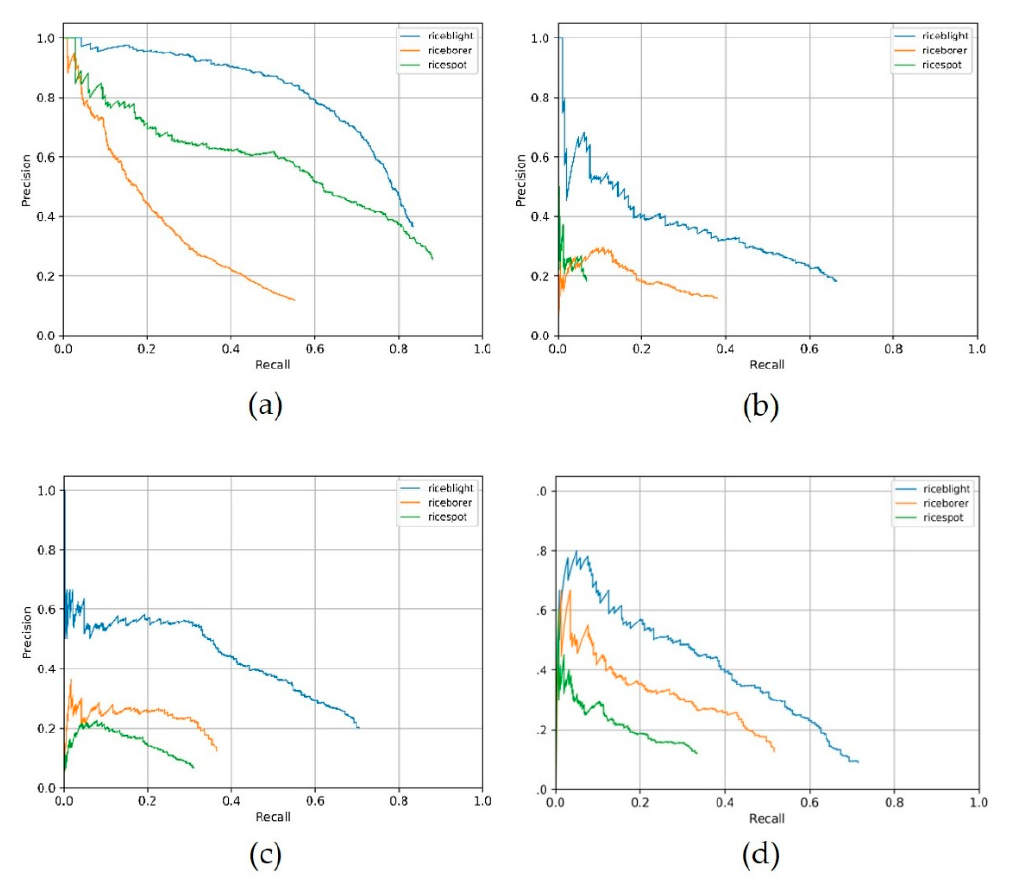
Figure 9. Precision-Recall curve of the still-image detector of the three other backbones and our custom DCNN backbone. Blue, yellow and green line denotes rice sheath blight, rice stem borer symptoms and rice brown spot respectively. ( a ) VGG16 with pre-trained model, ( b ) ResNet-50 with pre-trained model, ( c ) ResNet-101 with pre-trained model, ( d ) the custom DCNN training from scratch.